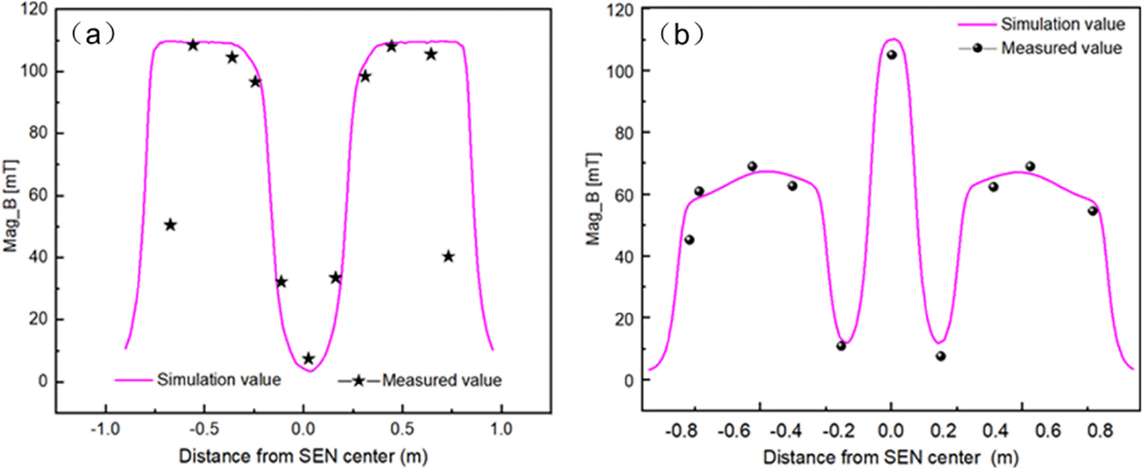
Figure 8. Feature line values compared with measured data. ( a ) Feature line 1 and ( b ) feature line 2.